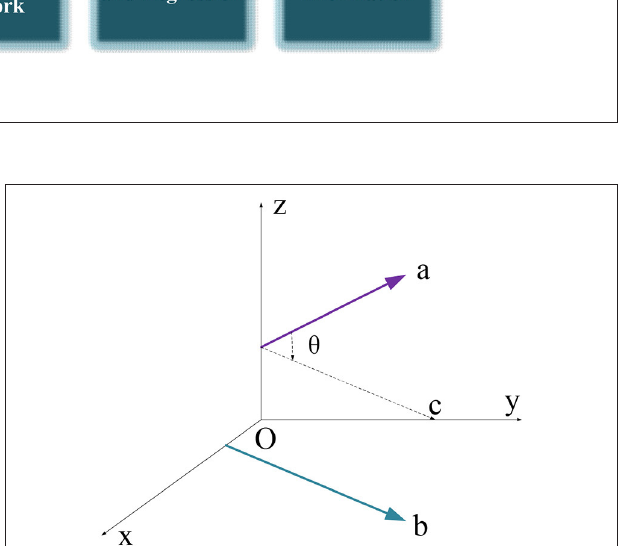
FIGURE 4 | Schematic diagram of the cross